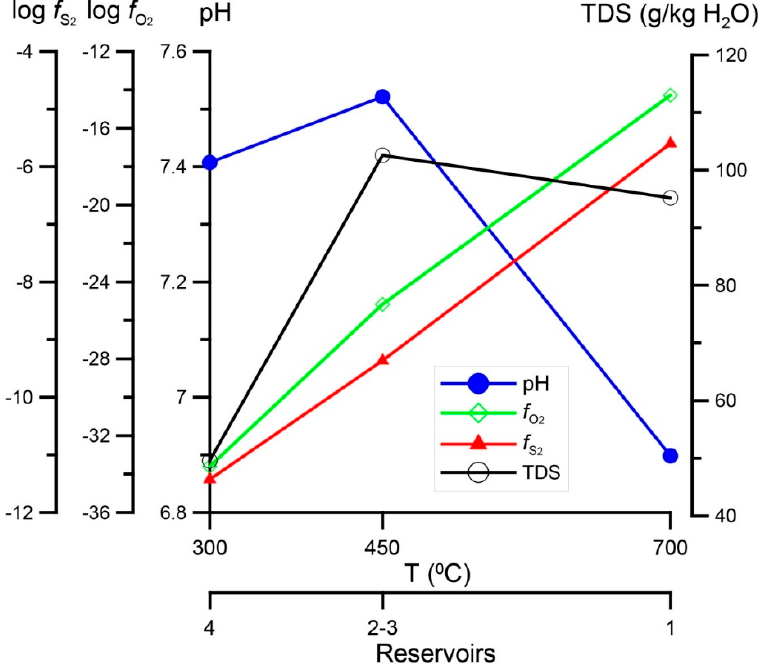
Figure 7. Variations in the values of pH, total dissolved solids (TDS), sulfur fugacity (log f S oxygen fugacity (log f O ) in different reservoirs. 2 2